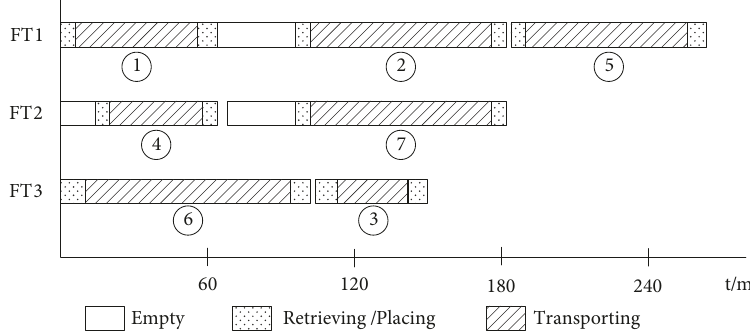
Figure 8: Gantt chart of a solution of block transportation scheduling.